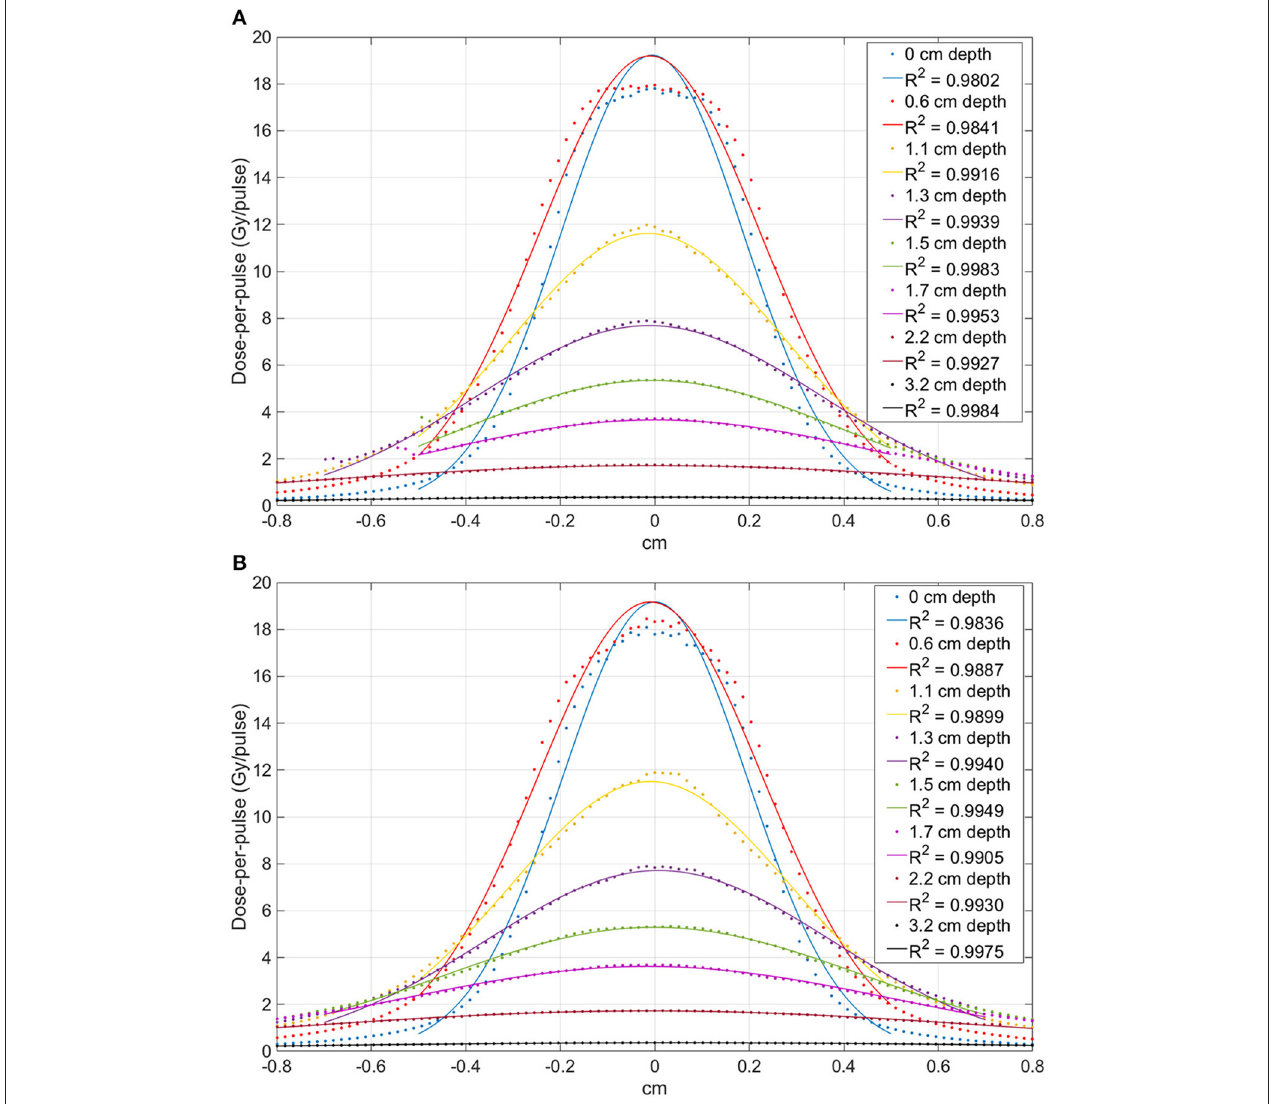
FIGURE 7 | Comparison between the profiles obtained at different depth with the FLASH beam 2. Image (A) shows the X-profiles while image (B) shows the Y-profiles. The superimposed continuous lines show the fit with a Gaussian function; R 2 values are reported for each curve.